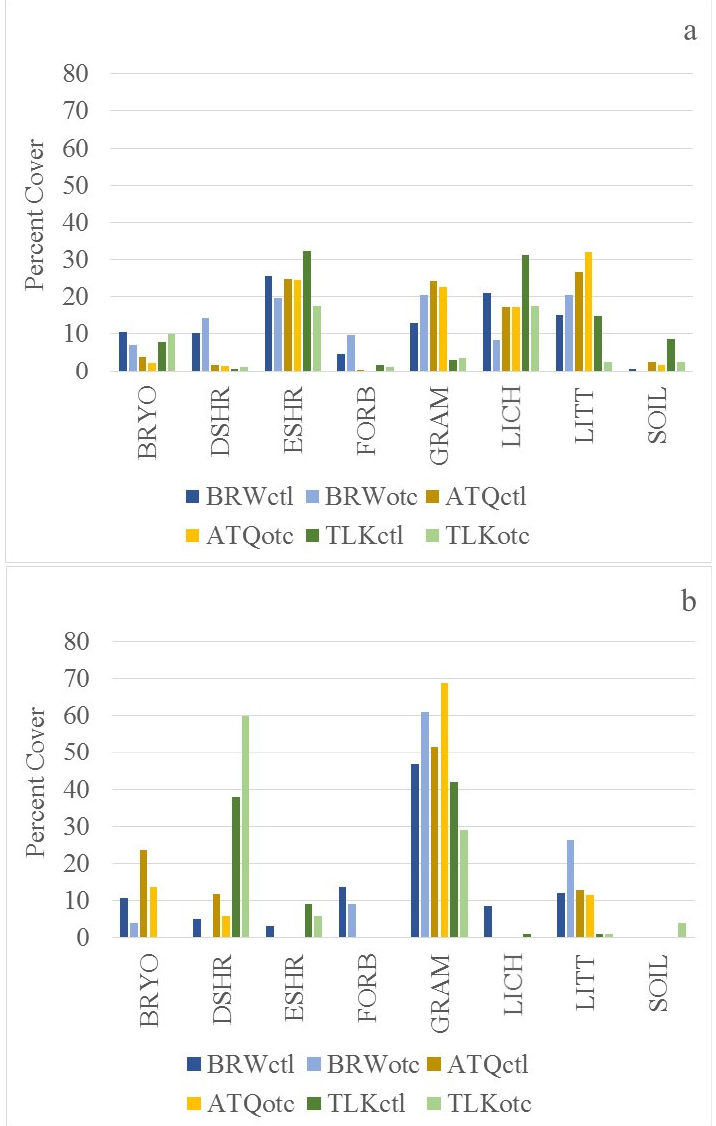
Figure 2. Aggregate percent cover of major plant growth forms and surface features at each site (BRW = Barrow; ATQ = Atqasuk, TLK = Toolik Lake) for dry ( a ) and wet/moist ( b ) moisture regimes (ctl = control, otc = open top chamber). Note: cover data were not available for all plots at Toolik Lake [25].